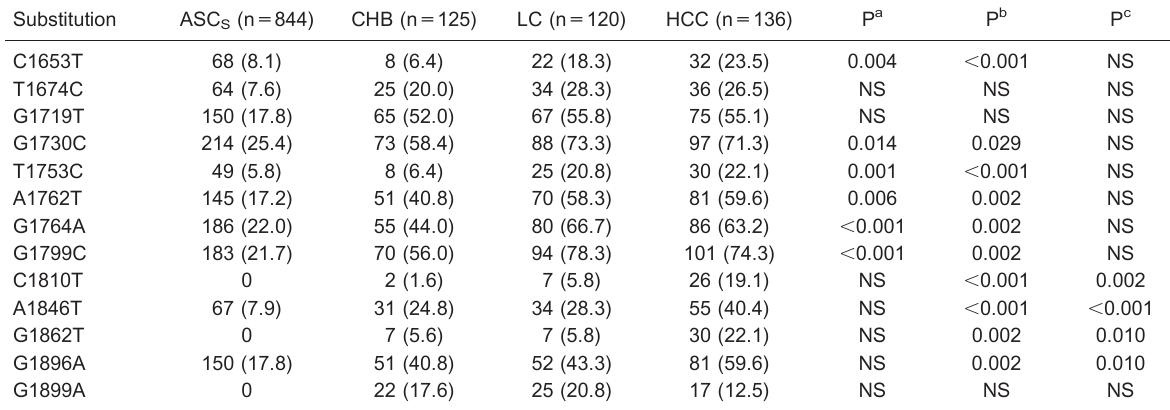
Table 4. Thirteen mutations in the enhII/BCP/precore regions of HBV in chronically infected patients.